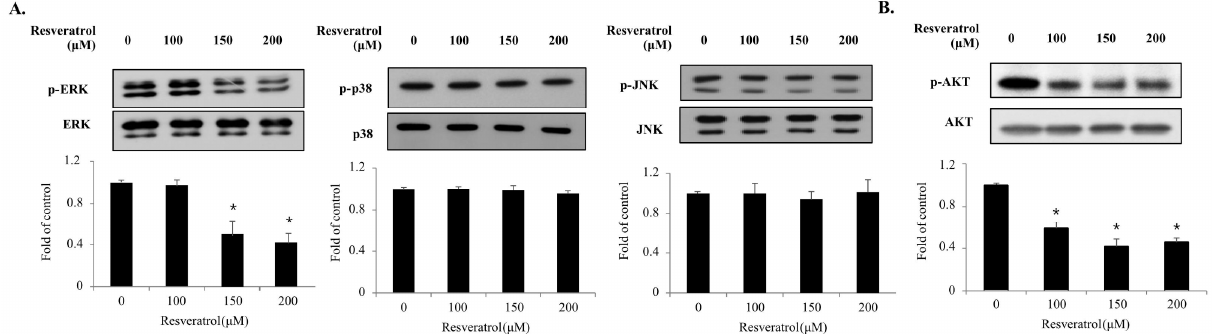
Figure 6. Phosphorylation of the MAPKs and PI3K/AKT signaling in WPMY-1 cells by resveratrol treatment. WPMY-1 cells were treated with various resveratrol concentrations (0, 100, 150, and 200 µ M) for 10 min. ( A ) The phosphorylation level of MAPKs was measured by immunoblots. Phosphorylation and total forms of JNK, ERK, and p38 were detected using specific antibodies. ( B ) AKT phosphorylation level was measured by immunoblots. Phosphorylation and total form of AKT were detected using specific antibodies of corresponding AKT. The data are expressed as mean ± SD as a result of three independent experiments depending on the resveratrol concentration (* p <